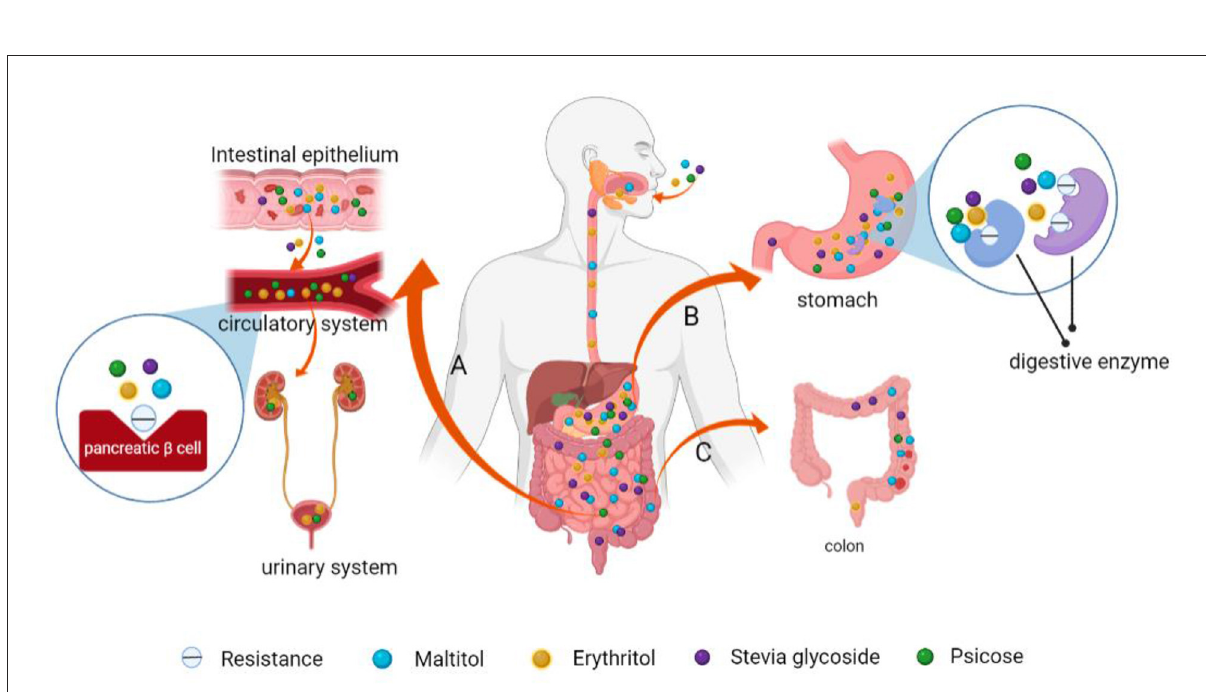
FIGURE7 Schematic presentation of the mechanisms of low GI and low calorie levels of maltitol, psicose, stevia glycoside and erythritol. (A) Psicose and erythritol enter the bloodstream and are subsequently eliminated via urine from the body through the kidney. They do not stimulate pancreatic β -cells to produce insulin and have limited effects on blood glucose levels. (B) These NSS are difficult to be broken down and be absorbed by digestive enzymes in the human gastrointestinal tract. (C) Indigestible NSS are excreted from the